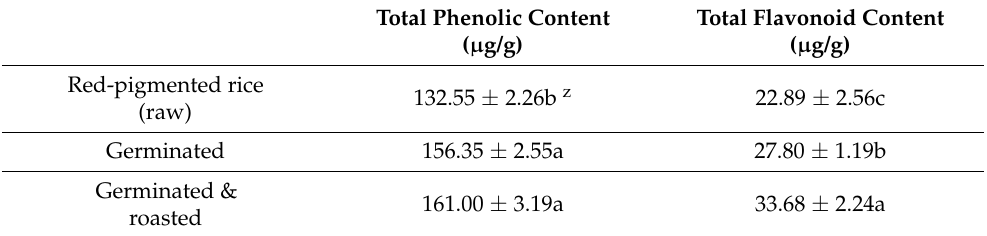
Table 3. Effects of germination and roasting on total phenolic and flavonoid contents of red-pigmented rice.